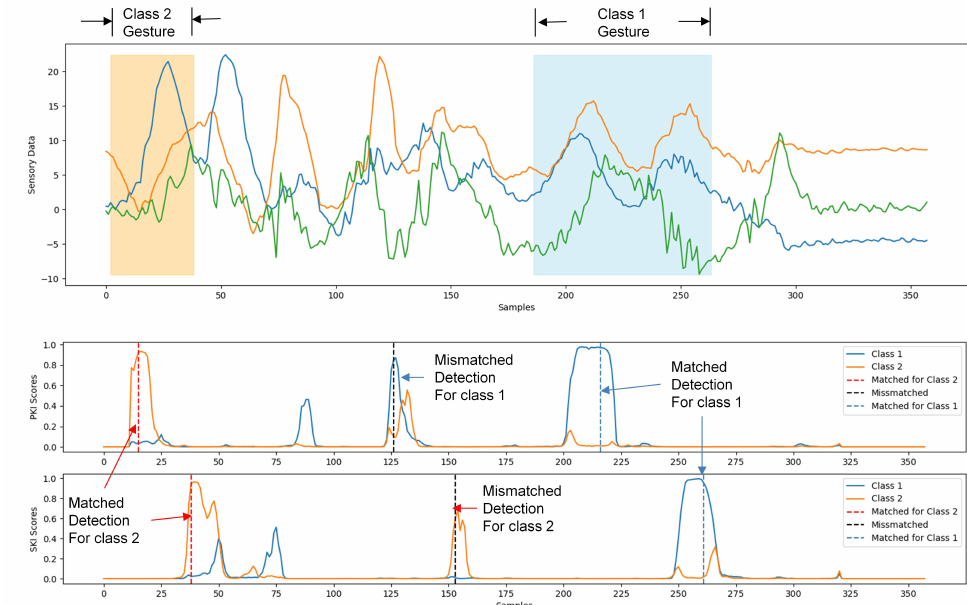
Figure 1. An example of the operations of the proposed SBR algorithm. The top graph of this example shows the sensory data from a 3-axis accelerometer. The second and third graphs reveal the PKI and SKI scores produced by the proposed network model, respectively. In the example, a matched detection for class 2 gesture is first identified. A number of mismatched detections are then followed. Finally, a matched detection for class 1 gesture is